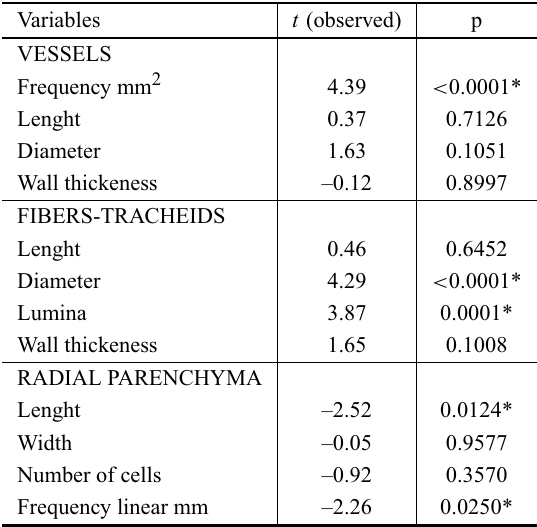
Student t test results for parameters analyzed in both plant formations ( α =